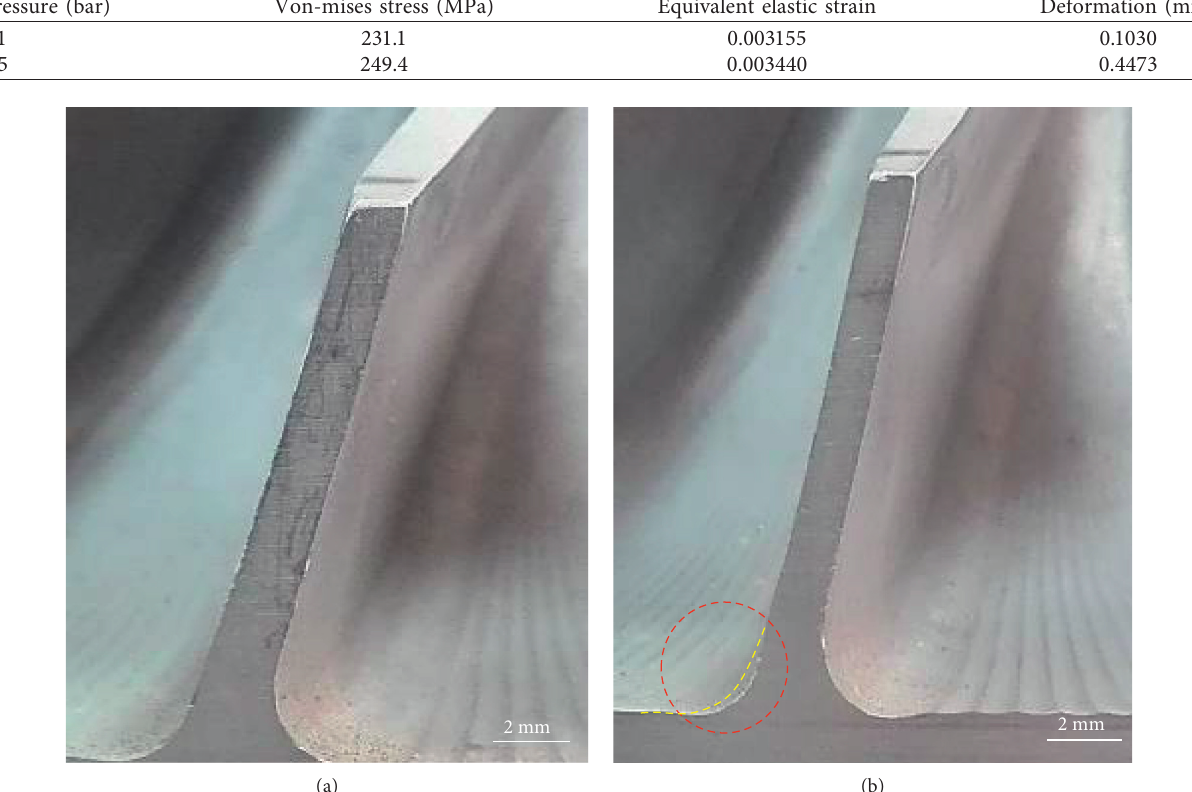
Figure 19: Camera image of sample 3 (a) before service (b) after service.